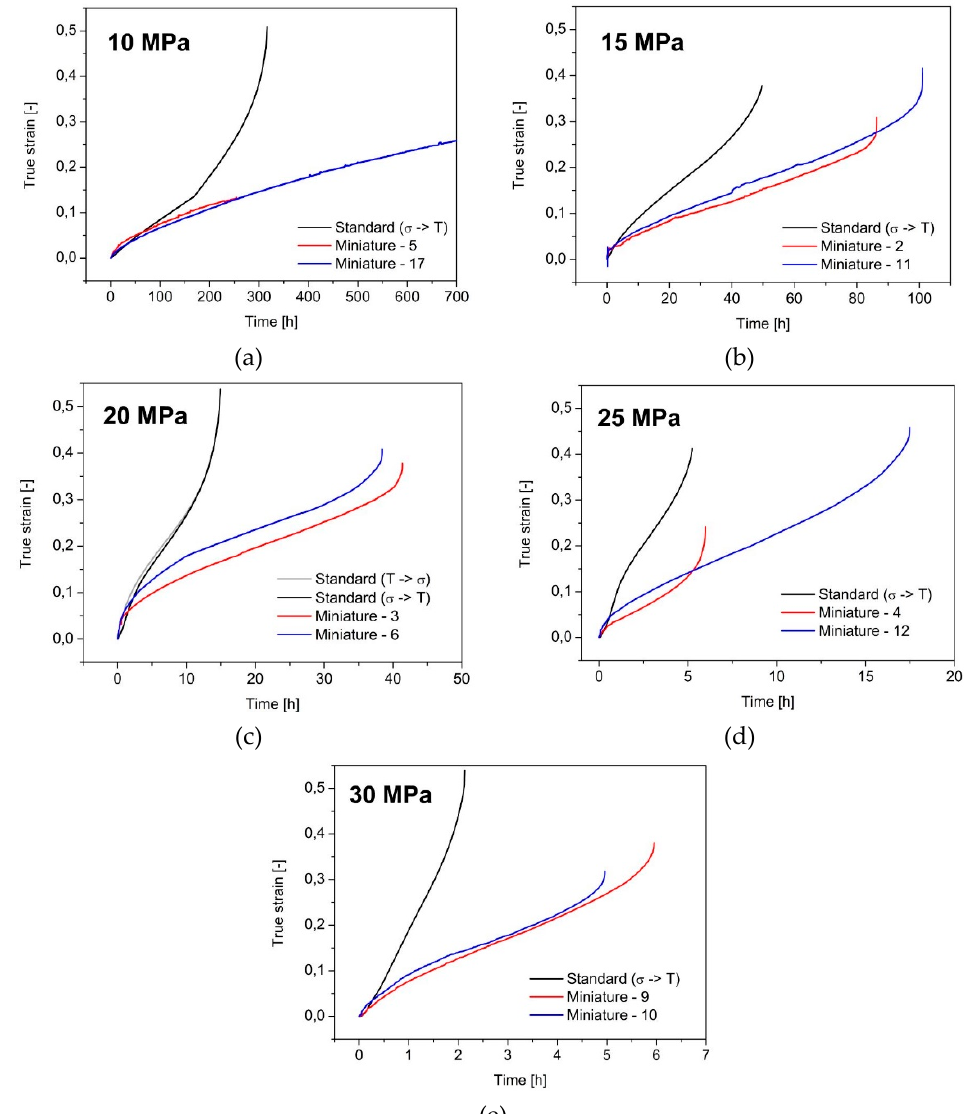
Figure 4. Creep curves, ( a ) 10 MPa, ( b ) 15 MPa, ( c ) 20 MPa, ( d ) 25 MPa, ( e ) 30 MPa.